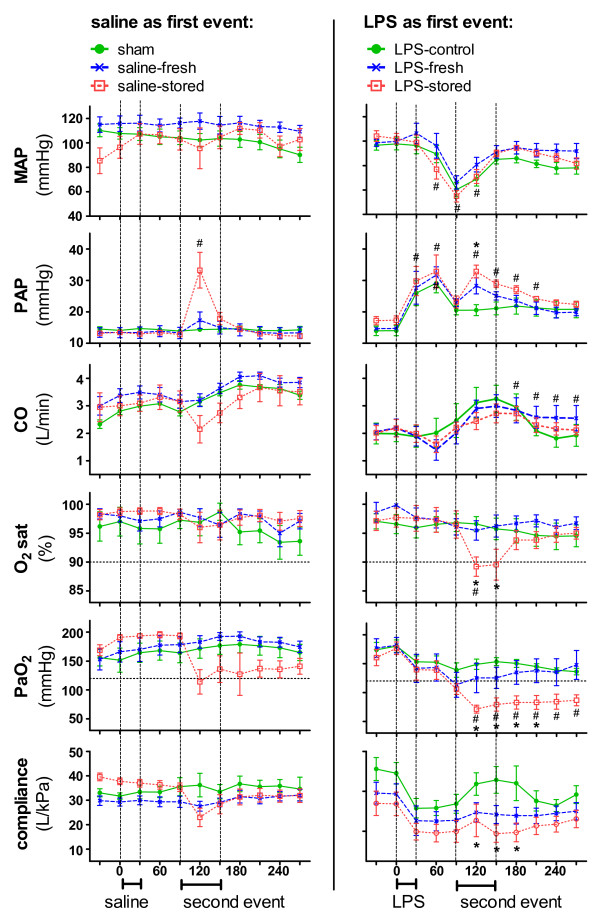
Haemodynamic and respiratory changes. Averaged data over 30-minute periods for each of the six groups of sheep. The first event (either saline or LPS) was infused from 0 to 30 minutes and the second event (either saline, "fresh PRBC" or "stored PRBC") was infused from 90 to 150 minutes. The left column represents sheep receiving saline-infusion as a first event (that is, sham, saline-fresh and saline-stored groups), and the right column represents sheep receiving LPS-infusion as a first event (that is, LPS-control, LPS-fresh and LPS-stored groups). Dashed lines at O2sat = 90% and PaO2 = 125 mmHg (FiO2 was 40%, therefore PaO2/FiO2 = 300) represent clinical cut-offs for hypoxaemia. LPS-stored sheep developed lower MAP, CO, PaO2, and O2 sat as well as higher PAP relative to sham sheep. Also, saline-stored sheep displayed increased PAP relative to sham sheep. # P < 0.05 vs. sham group using a two-way ANOVA with Bonferroni's multiple comparisons adjustment. LPS-stored sheep developed lower static pulmonary compliance, CO, PaO2, and O2 sat as well as higher PAP relative to the LPS-control group. * P < 0.05 vs. LPS-control using a two-way ANOVA with Bonferroni's multiple comparisons adjustment. ANOVA, analysis of variance; CO, continuous cardiac output; FiO2, fraction of inspired oxygen; "fresh PRBC," pooled heat-inactivated supernatant from Day 1 human PRBC; LPS, lipopolysaccharide; MAP, mean arterial pressure; O2sat, oxygen saturation; PaO2, arterial partial pressure of oxygen; PAP, pulmonary artery pressure; "stored PRBC," pooled heat-inactivated supernatant from Day 42 human PRBC; TRALI, transfusion-related acute lung injury.